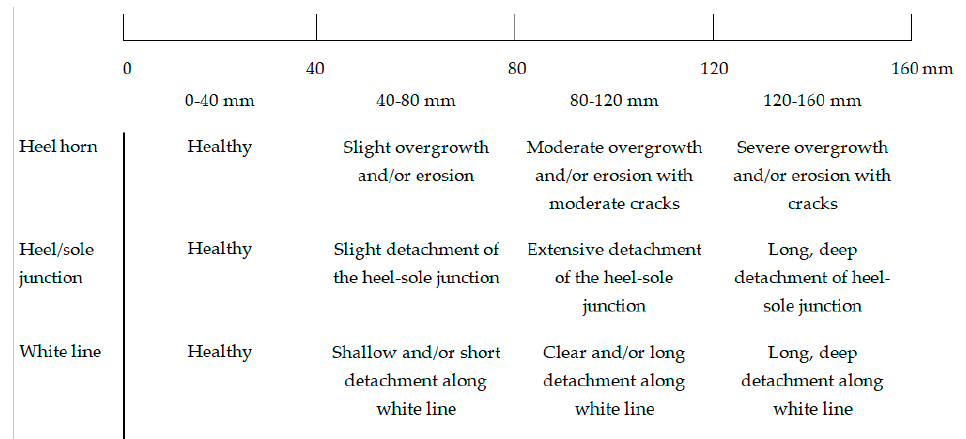
Figure 6. Tagged visual analogue scale (tVAS) for claw lesion scoring in sows, adapted and modified from the scorings methods of Wageningen University and FeetFirst (Zinpro Corp., Eden Prairie, MN) as described in [9,10,31]. To score the claw area for claw lesions, a vertical bar was drawn on the line and the distance from 0 mm determined, reflecting the severity of a claw lesion.